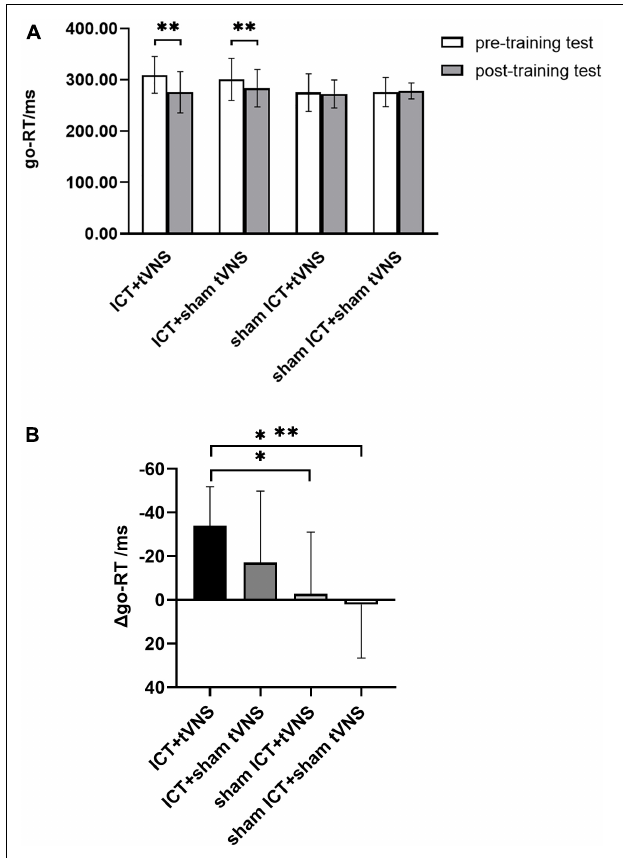
FIGURE 4 | (A) The performance of Go/No-go tests: go-RT of the Go/No-go between pre- and post-training tests. (B) The performance of Go/No-go tests: The decrement of the go-RT for each group. ∗ P < 0.05, ∗∗ P < 0.01, Error bars represent the standard error of the mean.